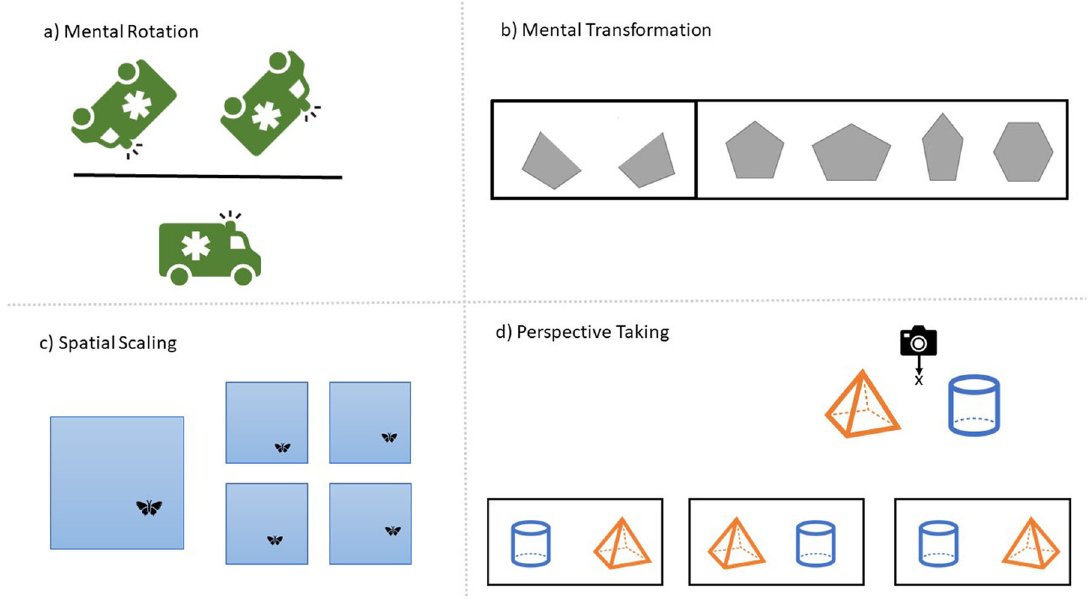
Fig. 1 Sample spatial tasks used to assess different spatial skills. a Mental Rotation, participants must choose which image above the line is the same as the image below the line. b Mental Transformation, participants must select which shape on the right can be formed by combining the two shapes on the left. c Spatial Scaling, participants must select which of 4 small pictures shows the butter fl y in the same position in the sky as the larger picture. d Perspective Taking, participants must choose which photograph from the three options at the bottom, would be taken if a photographer was standing at position